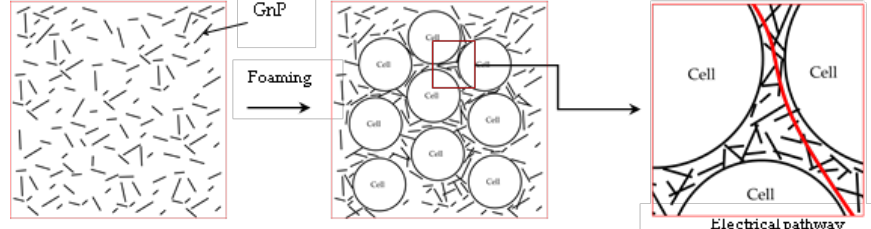
Figure 8. Detail of GnP dispersion showing the microstructural changes in a polymer foam containing GnP with foaming and the effects in electrical conduction.